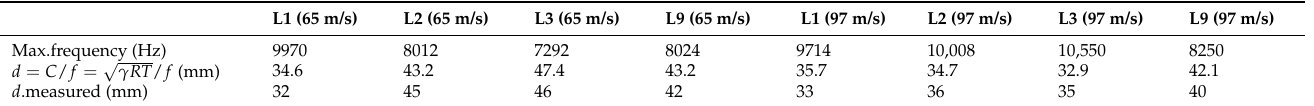
Figure 16. Feedback channels and mixing chamber instant velocity, pressure, density and temperature fields. Power nozzle velocity, 97 m/s, feedback channel length, L9. Table 1. Comparison of the distance between two consecutive pressure waves measured versus the calculated